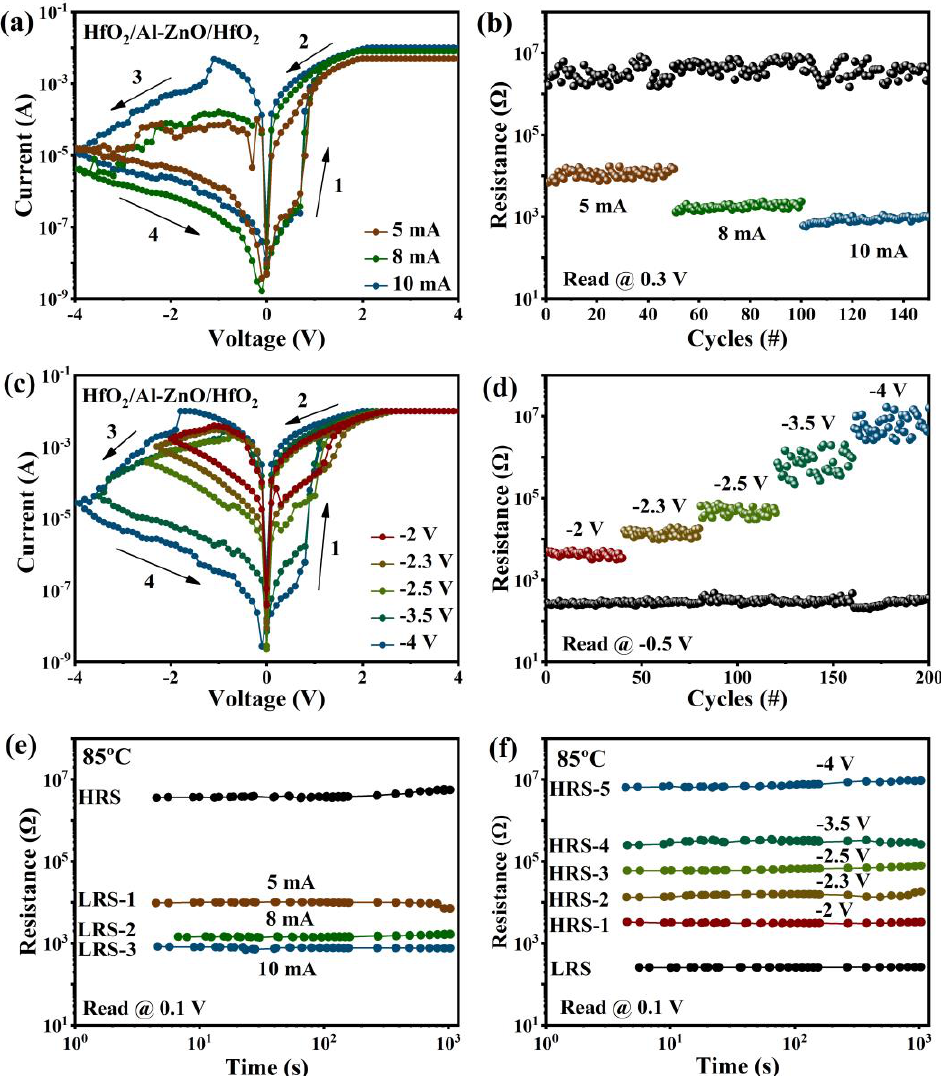
Figure 5. Multi-level storage characteristics of Au/HfO 2 /Al-ZnO/HfO 2 /ITO memory device: ( a ) I – V characteristics of different compliance currents (5 mA, 8 mA, and 10 mA); ( b ) resistance distribution of high-/low-resistance states corresponding to different compliance currents (5 mA, 8 mA, and 10 mA), read at 0.3 V; ( c ) I–V characteristics at different stop voltages ( − 2 V, − 2.3 V, − 2.5 V, − 3.5 V and − 4 V); and ( d ) high-/low-resistance state resistance distribution corresponding to different reset stop voltages ( − 2 V, − 2.3 V, − 2.5 V, − 3.5 V, and − 4 V), read at − 0.5 V; ( e ) retention of resistance states under different compliance currents; and ( f ) retention of resistance states under different stop voltages.